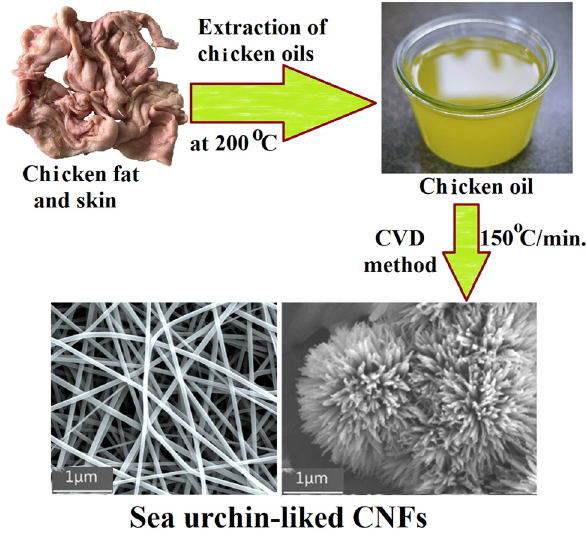
Figure 4: ( Bottom ) SEM images of CNFs synthesized using waste chicken fat. Copyright © 2015, Elsevier Publishing Group [ 362 ]